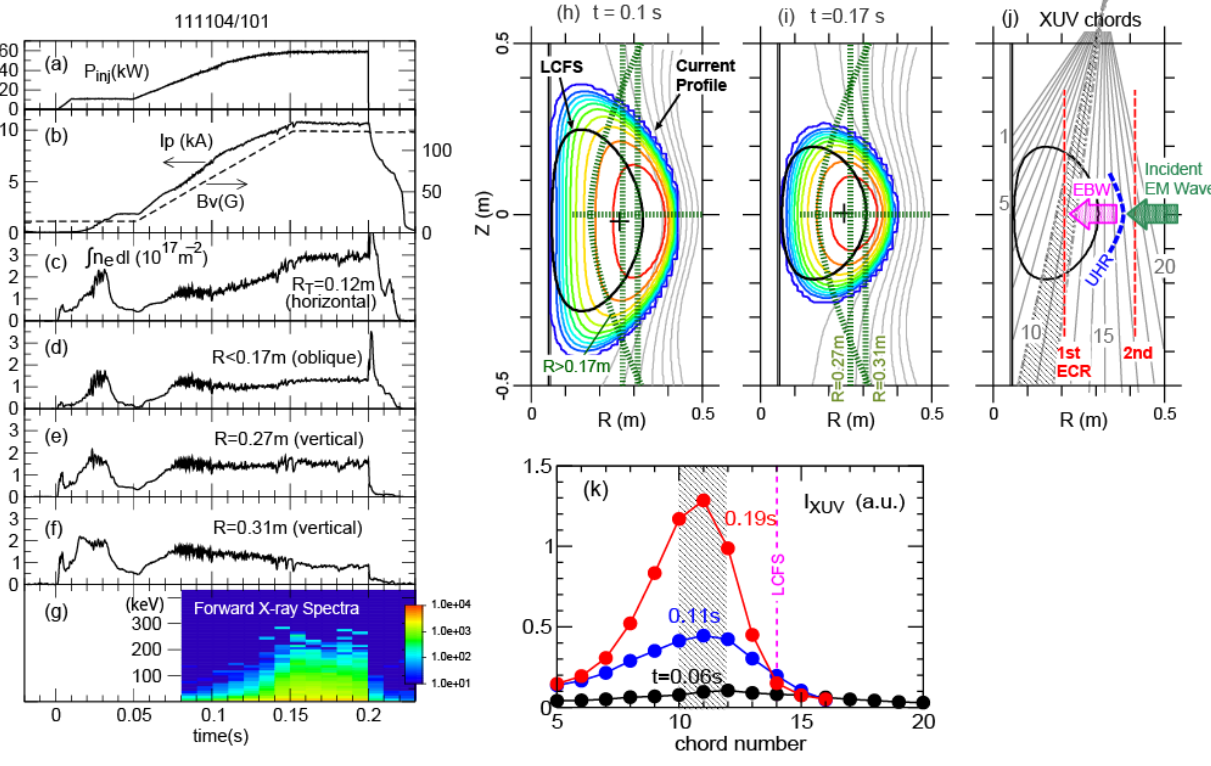
Figure 2. Typical discharge. (a) Injection power of 2.45GHz microwave, (b) Plasma current and vertical field strength at R=25cm, (c) Holizontal chord line-integrated density at a tangency radius of Rt=12cm, (d)-(f) Oblique and vertical chords line-integrated densities, (g) Forward X-ray emission from current carrying electrons measured along a tangency radius of Rt=25cm, (h) Current density and poloidal flux contours estimated from the magnetic analysis. Contours are equally spaced. Interferometer chords are also shown, (i) XUV chords and (k) XUV intensity